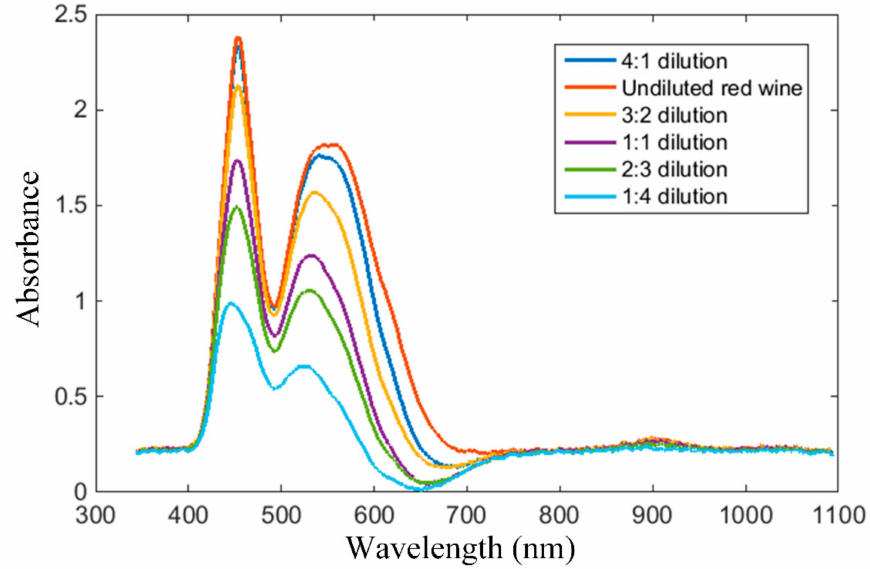
Figure 17. Feteasc ă Neagr ă red wine absorption spectra, acquired with the point sensor, for di ff erent dilutions of wine in